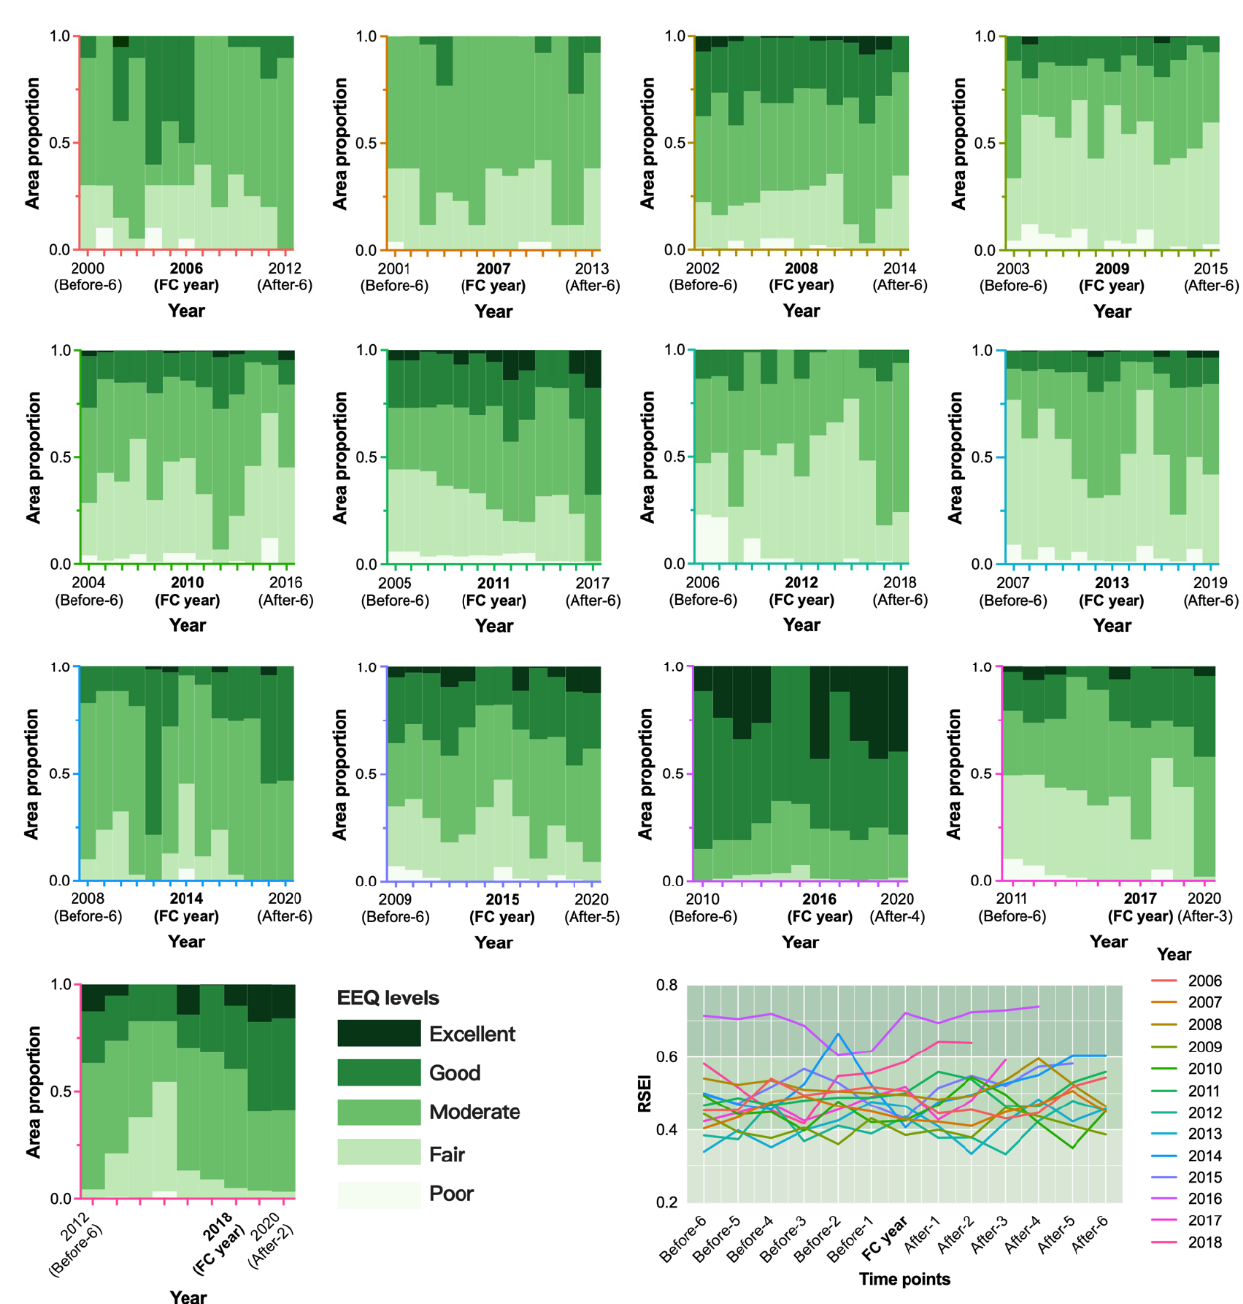
Figure 6. Area proportion of EEQ levels in each FC phase. The EEQ levels are same as before. Moreover, we exhibited the changes in the average RSEI from the 6 years before FC to the 6 years after FC in each FC phase.